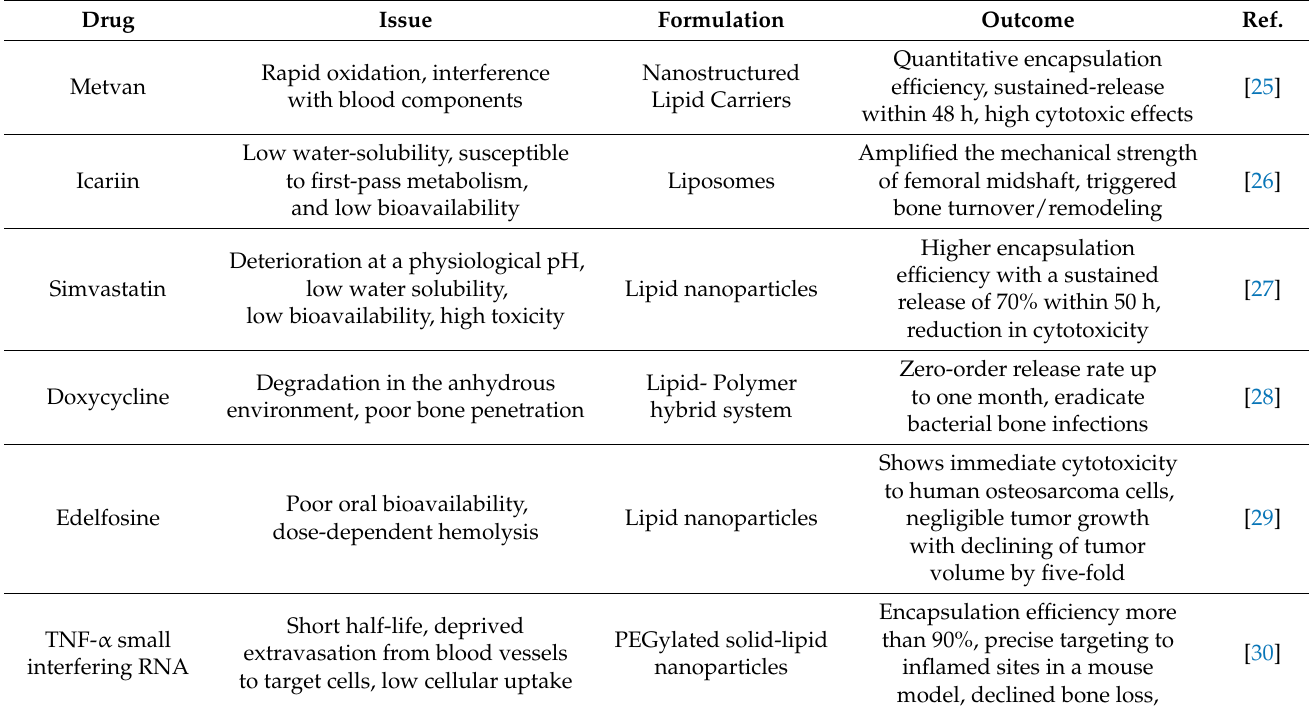
Table 1. Issues related to drugs in bone